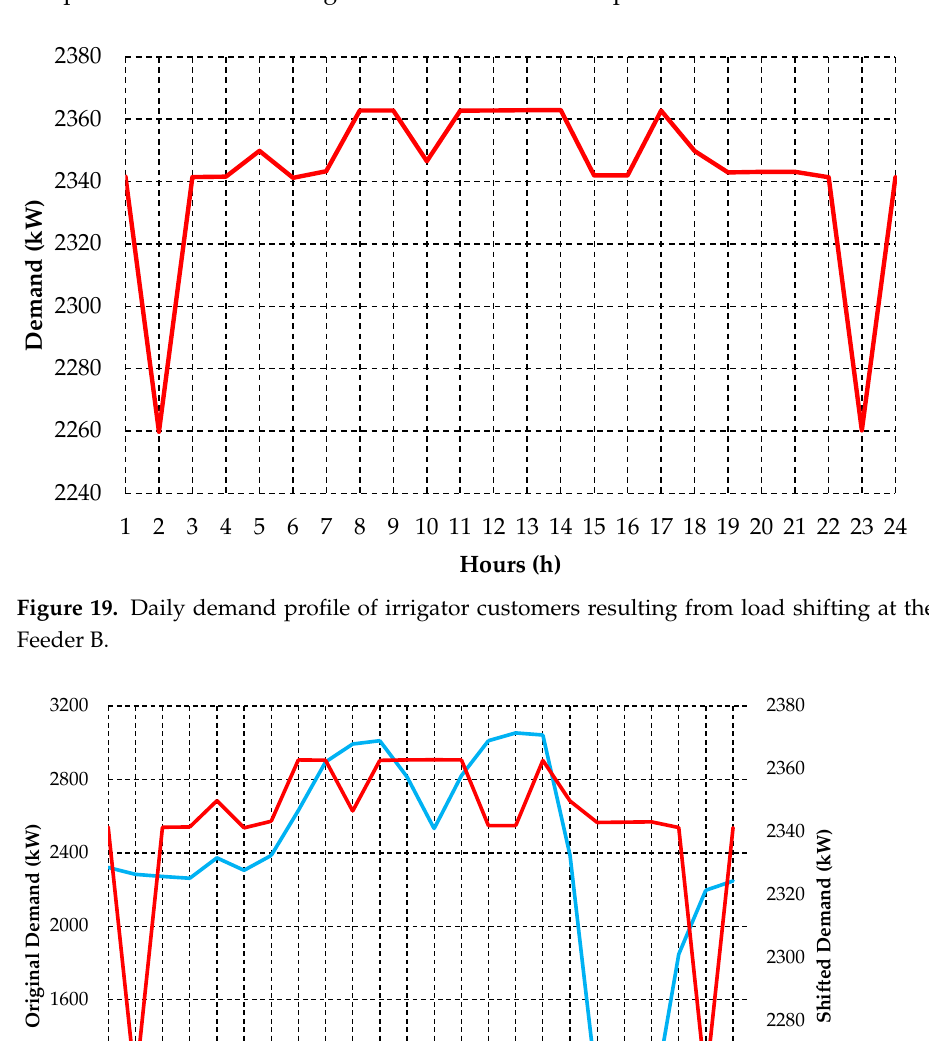
Figure 18. Daily demand profile of the irrigator customer group present at the Rural Feeder B.